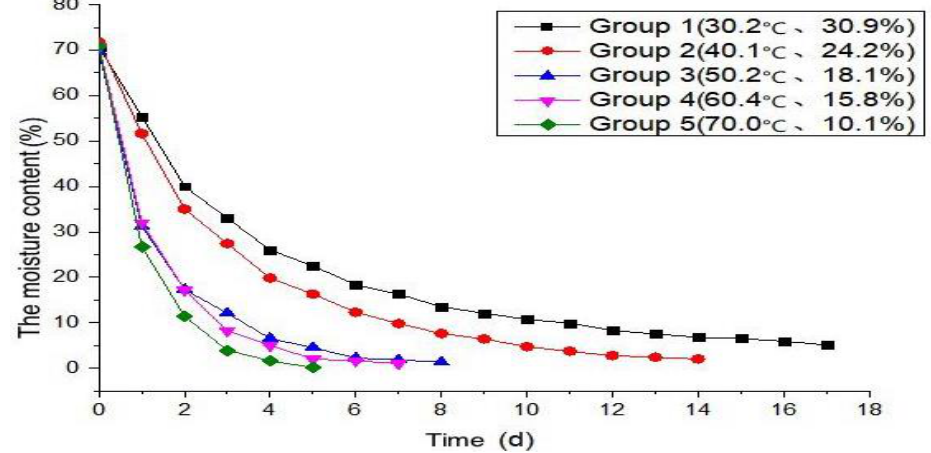
Figure 2. Moisture content of five specimens with time under different test environments.